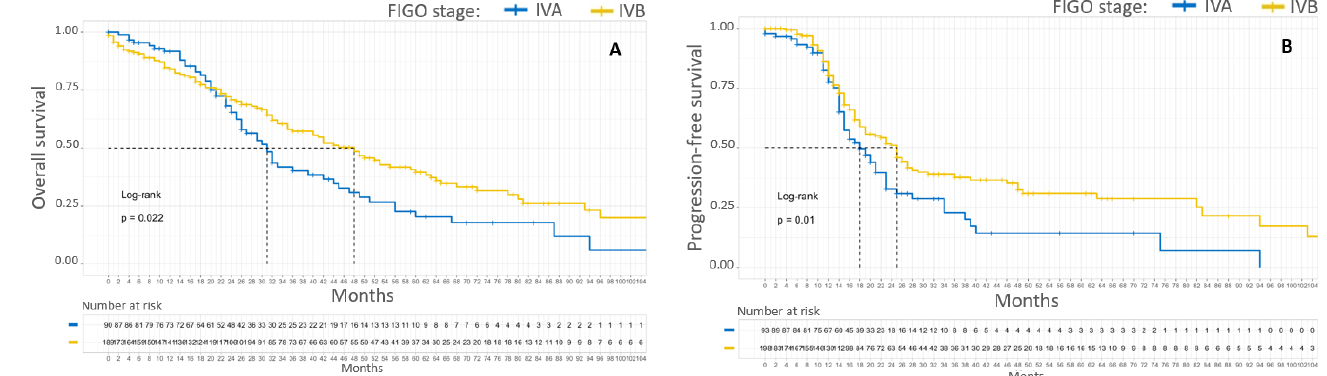
Figure 2. Kaplan – Meier OS ( A ) and PFS ( B ) curves for patients with FIGO stage IV EOC. In blue, patients with stage IVA EOC. In yellow, patients with stage IVB EOC.